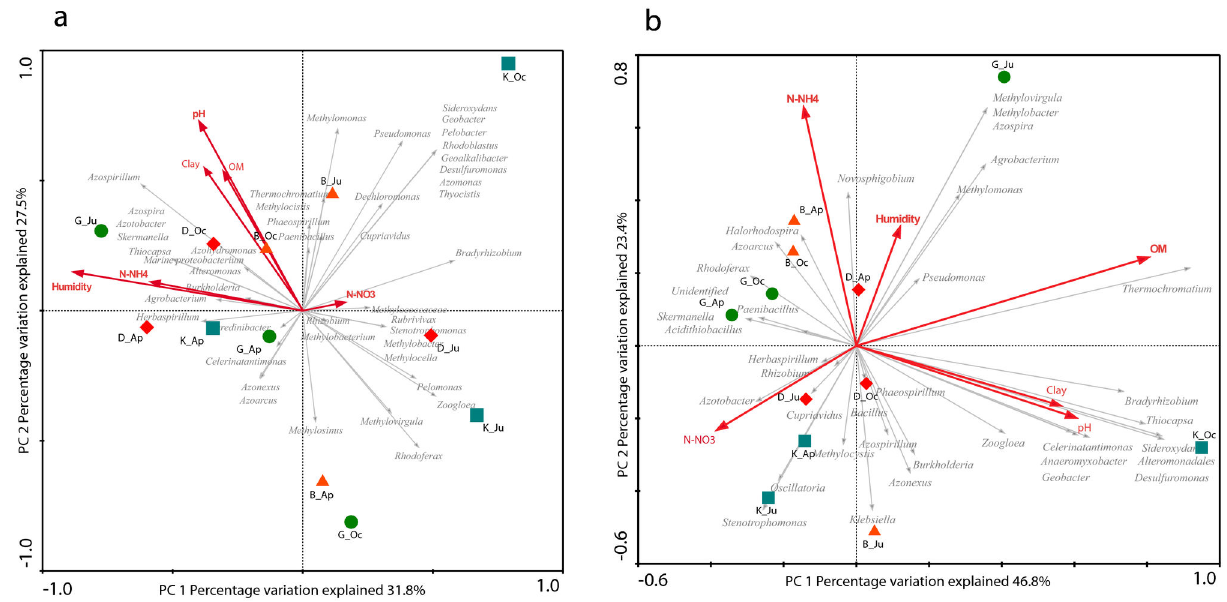
Figure 6. Changes in the structure of N-fixing communities from nif H-gene pyrosequencing across different soils and sampling times. Changes in the structure of nif H-gene communities and the influence of environmental parameters as revealed by RDA, considering (a) the most abundant and (b) rare sequences. The number in each axis shows the percentage of total variation explained. The length of the corresponding arrows indicated the relative importance of the geochemical factor in explaining the variation in microbial profiles. Soil samples were analyzed in four replicates at each sampling time. B, Buinen; D, Droevendaal; K, Kollumerwaard and G, Grebbedijk; Ap, April; Ju, June; Oc,